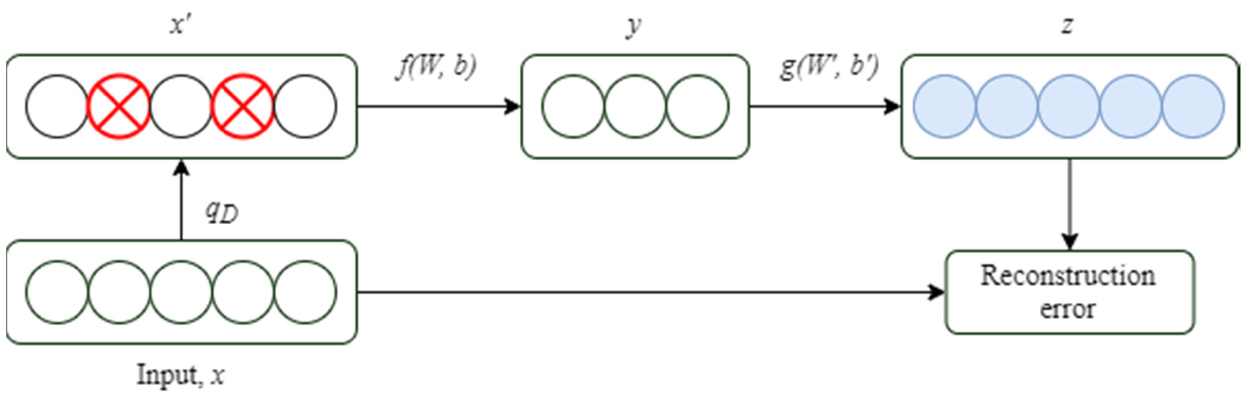
Figure 6. Structure of noise reduction self-coding network.